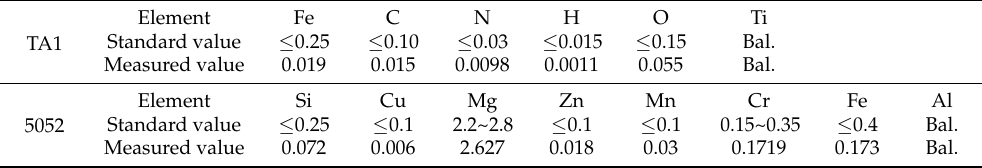
Table 1. Chemical compositions of TA1 and 5052 alloys.